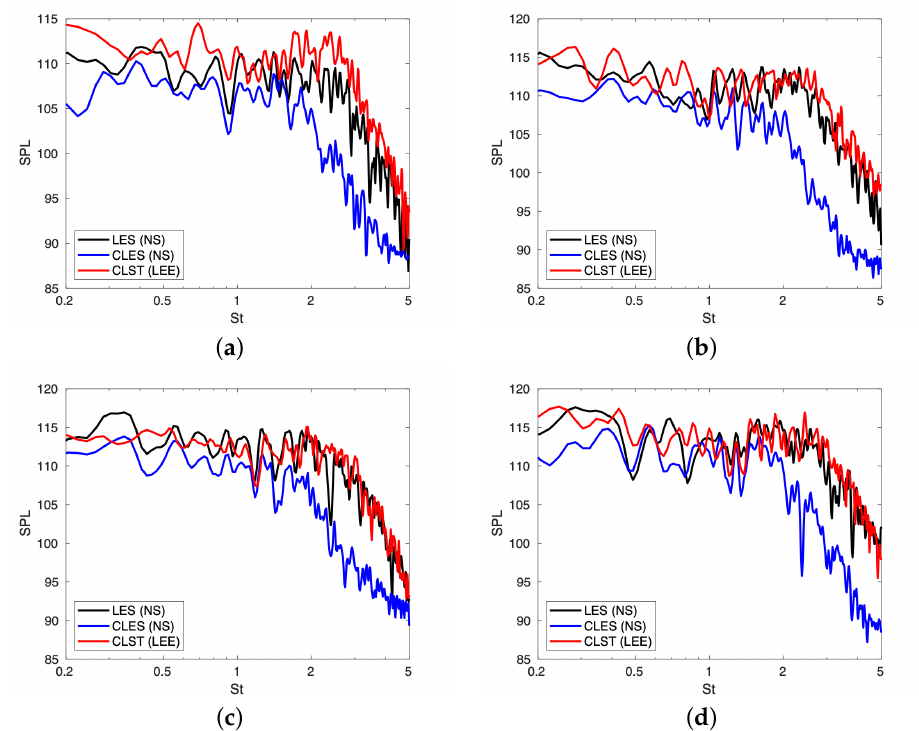
Figure 11. SPL Spectra for CLST along the Line y = 5D j : ( a ) Point P1 (x = 1D j ). ( b ) Point P2 (x = 2D j ). ( c ) Point P3 (x = 3D j ). ( d ) Point P4 (x = 4D j